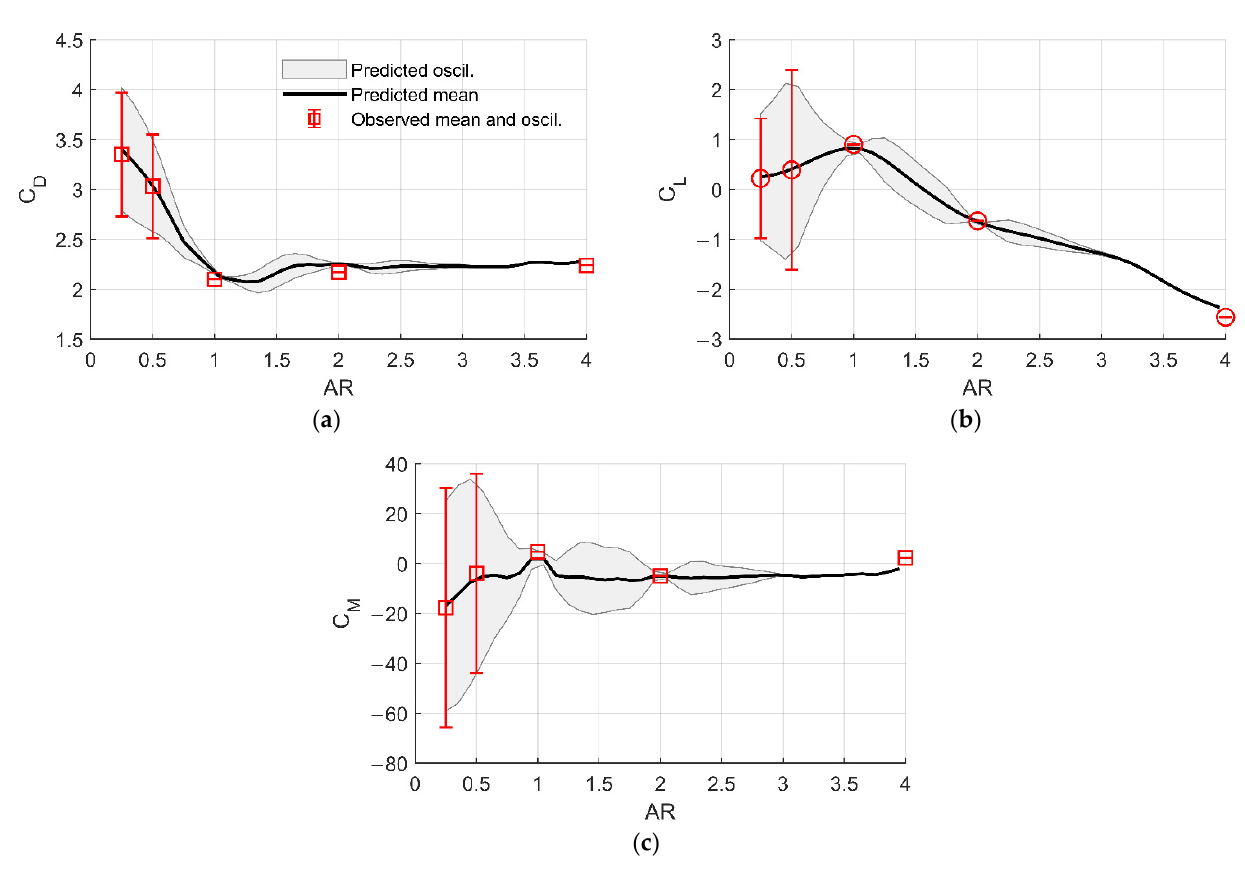
Figure 7. Comparisons of predicted hydrodynamic pressure coefficients with observed values from Nguyen et al. [9]: ( a ) Drag, ( b ) Lift, and ( c ) Moment coefficients.